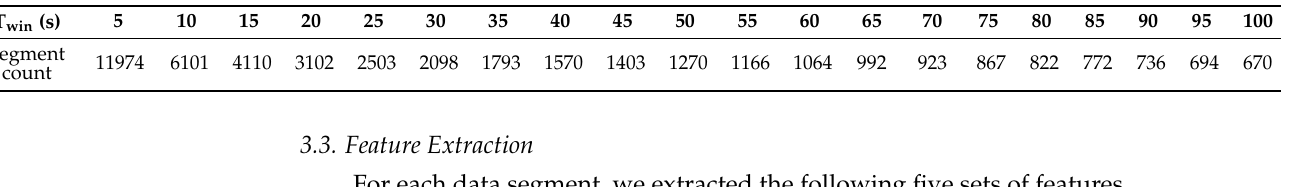
Figure 2. Data segmentation. ( a ) If a recording = 48 s and T win = 8 s, the recording is divided into 6 segments; ( b ) for the same recording, if T win = 10 s, the recording is divided into 4 segments and the last 8 s is ignored. Table 2. Number of segments in each time window size.